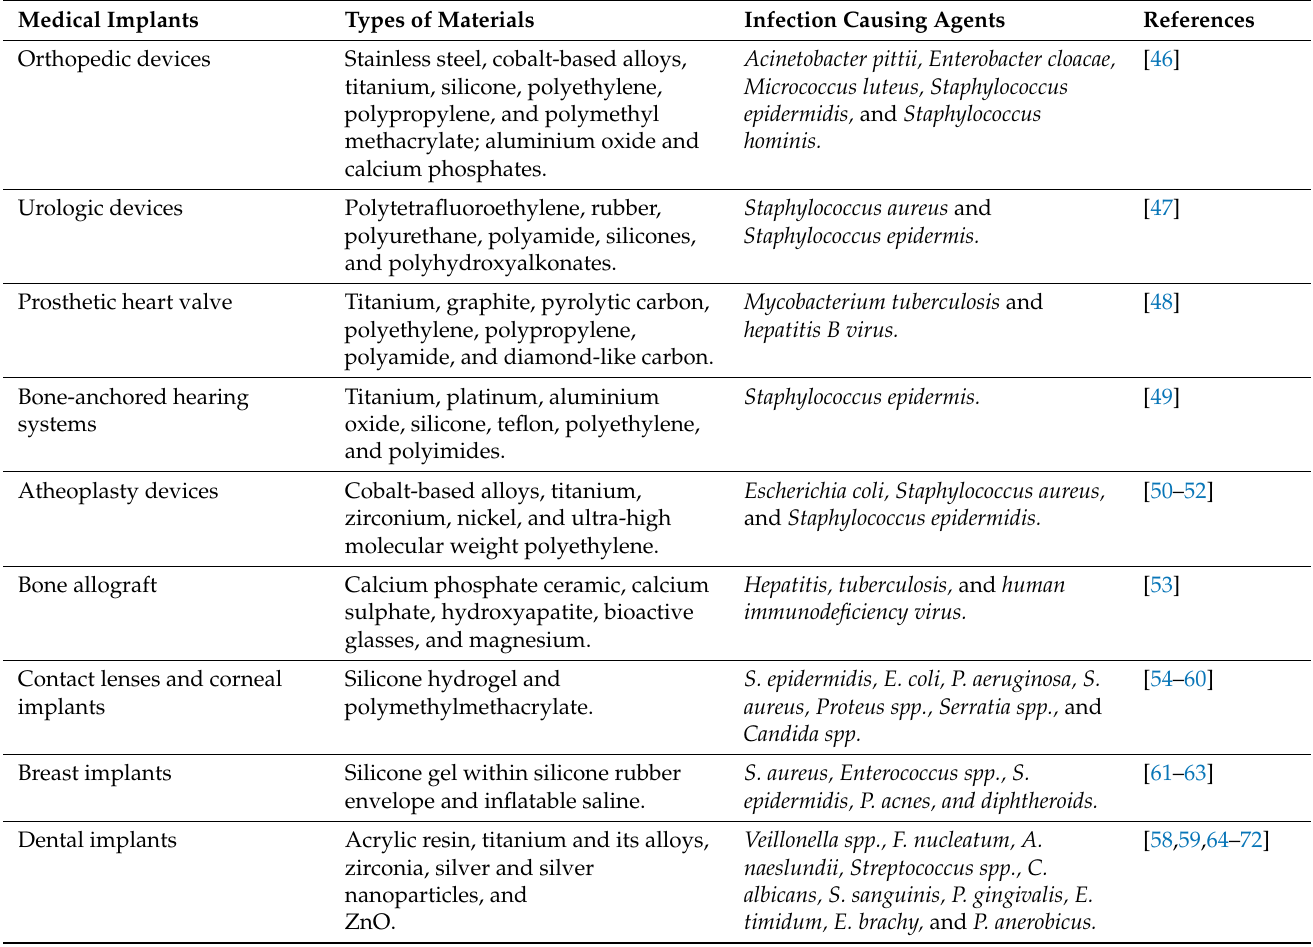
Table 2. Commonly reported infection in medical